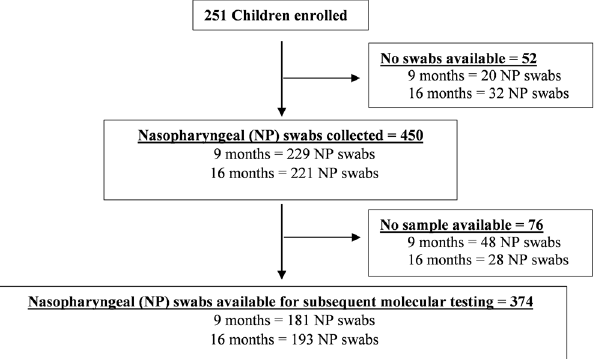
Figure 1. Flow Diagram of study population and sample availability. Diagram indicating the number of children initially enrolled in a PCV-unvaccinated cohort of HIV-uninfected children, as well as the number of nasopharyngeal (NP) swabs available for subsequent molecular qPCR analysis. No swabs were collected due to a missed study visit and the number of NP swabs available for molecular testing were defined by whether there was an adequate volume of sample remaining.